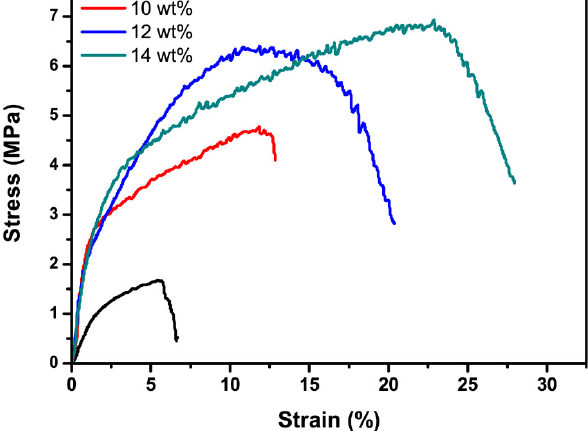
Figure 7: Tensile stress-strain curves with different concentrations